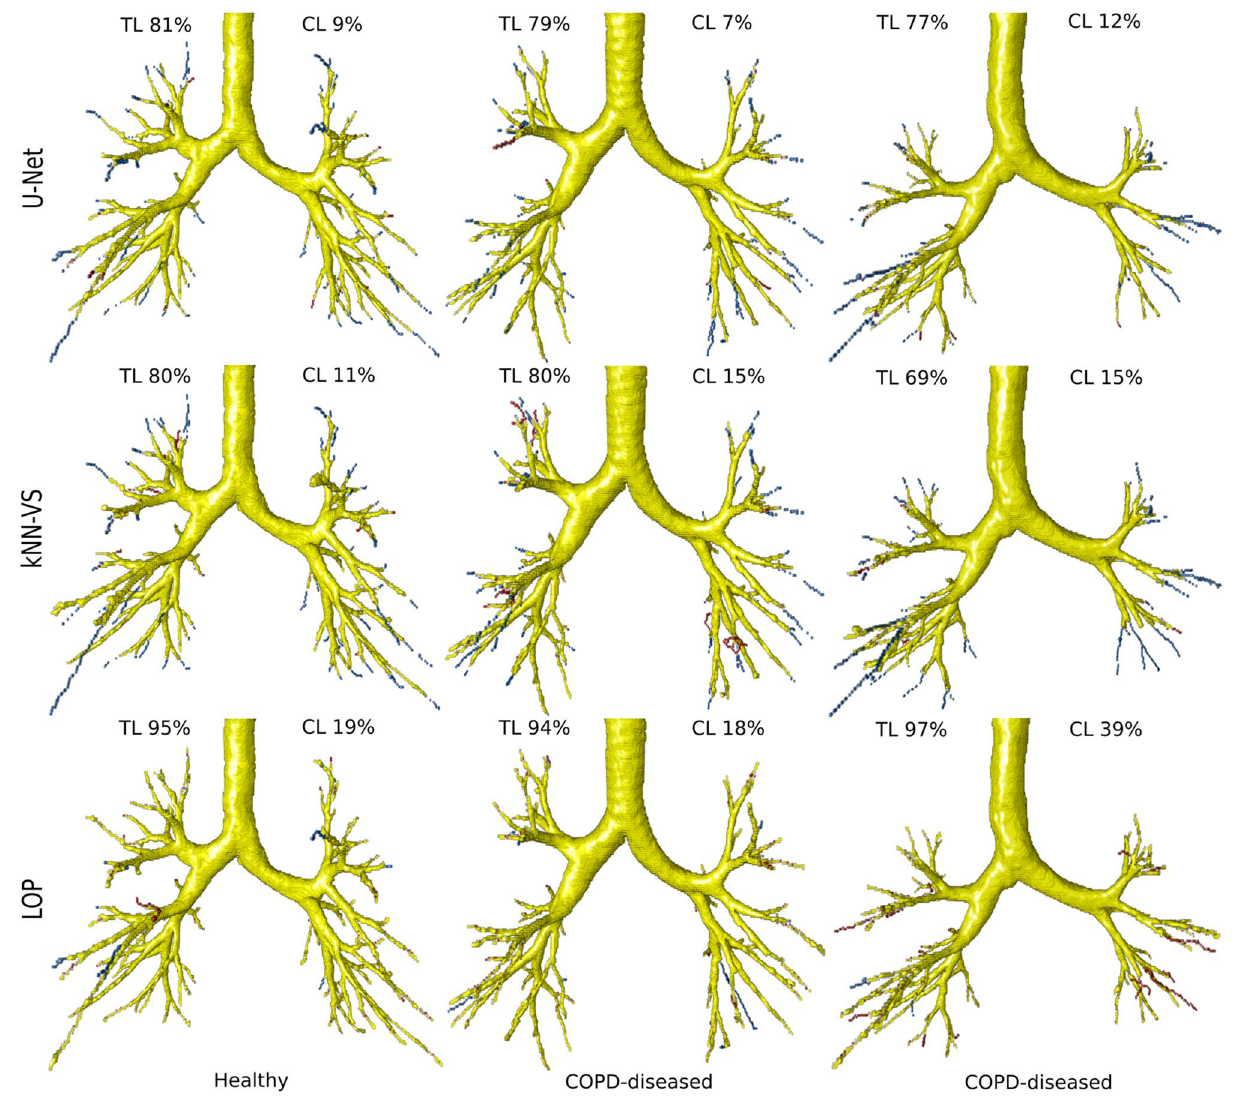
Figure 5. Visualization of predicted airways trees on the DLCST data, obtained by our U-Net-based method and the kNN-VS 9 and LOP 10 methods. True positives are displayed in yellow, centerline false negatives in blue and centerline false positives in red. These false negatives and positives are the errors counted in the tree length detected and centerline leakage measures reported in Fig. 4, respectively. The cases displayed correspond to, from left to right, the two U-Net results with Dice score closest to the median of the test Dice measures, and the U-Net result with the lowest Dice Through visual inspection of the results, we observed that for some CT scans a large number of airways predicted by our U-Net-based method that were reported as false positives in the EXACT’09 evaluation are real